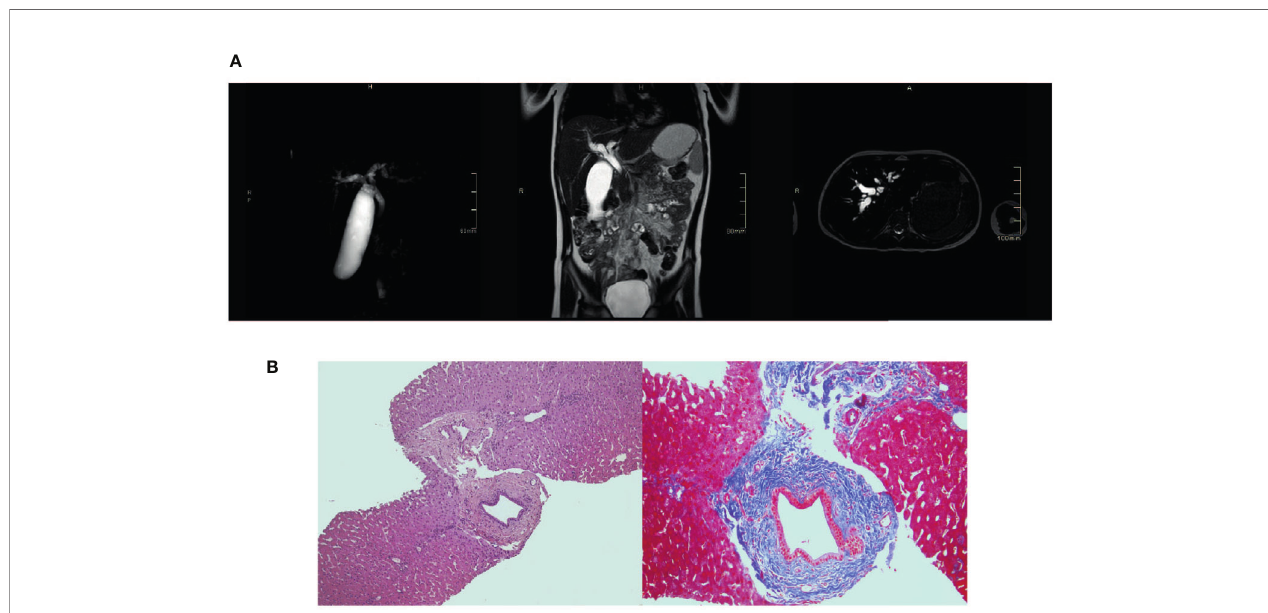
FIGURE 2 | Sclerosing cholangitis in the index patient. (A) Upper abdomen magnetic resonance showing diffuse and marked enlargement of intra- and extrahepatic bile ducts. (B) Liver biopsy showing one dilated duct with “ onion-skin ” type of periductal fi